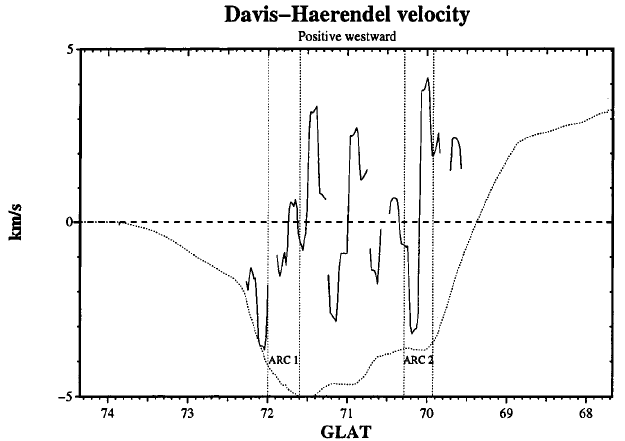
Fig. 9. The perpendicular velocity according to Davis-Haerendel suggestion, applied to our event. The FAST potential from Fig. 7 (in kV) is shown as a visual aid ( dotted